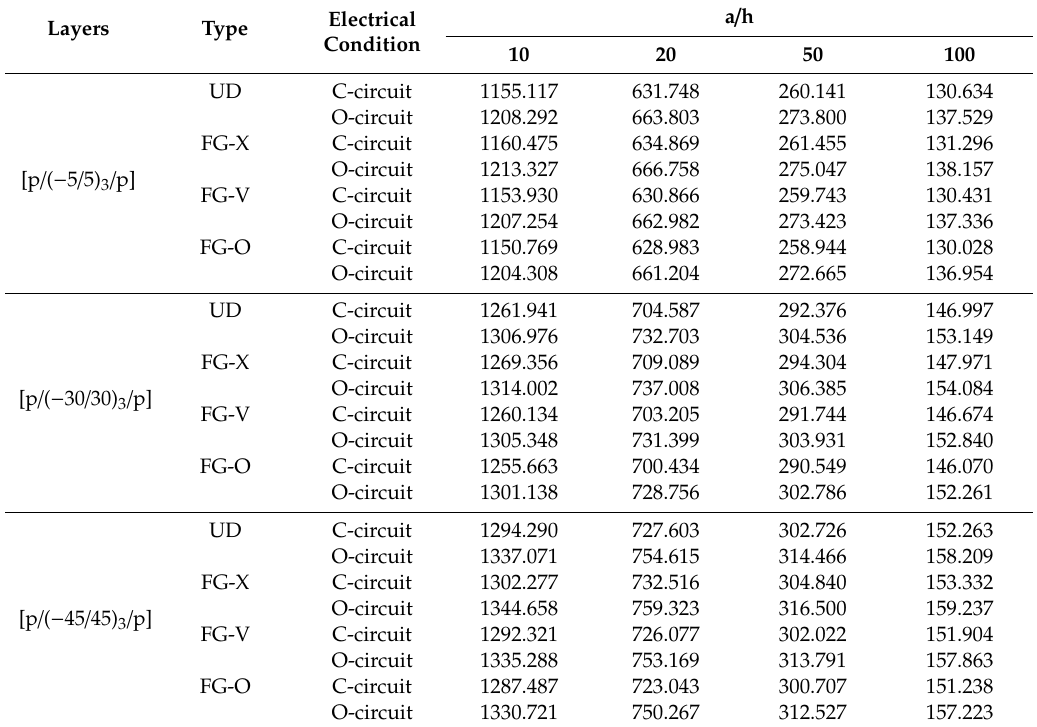
Table 10. The fundamental natural frequencies ω (Hz) of anti-symmetric angle-ply [p / ( − θ / θ ) 3 / p]